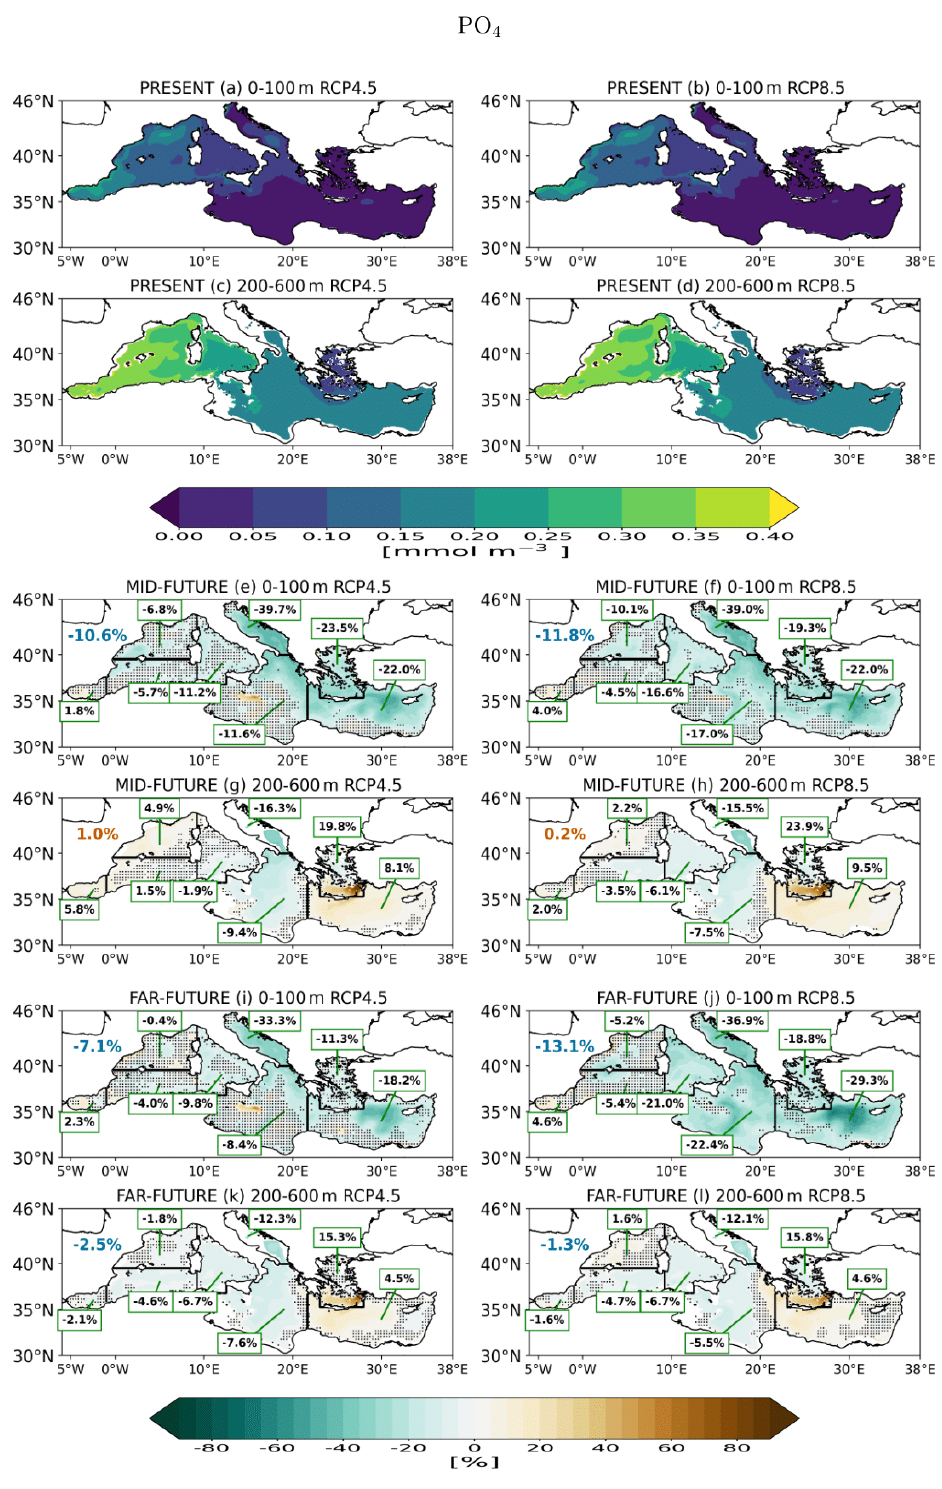
Figure 5. Phosphate concentrations (in mmolm − 3 ) in the 0–100 and 200–600m layers in the PRESENT (2005–2020, a , b , c and d ), and relative climate change signal (with respect to the PRESENT, in %) in the MID-FUTURE (2040–2059, e , f , g and h ) and FAR-FUTURE (2080–2099, i , j , k and l ) in the RCP4.5 (a, c, e, g, i, k) and RCP8.5 (b, d, f, h, j, l ) emission scenarios. The Mediterranean average relative climate change signal in each period (with respect to the PRESENT) is displayed as a colored value (blue or dark orange when negative or positive, respectively) shown in the top left of the subfigure. Values in green boxes are the average relative climate change signals for particular periods and sub-basins shown in Fig. 1. Domain grid points where the relative climate change signals are not statistically significant according to a Mann–Whitney test with p< 0 . 05 are marked by a